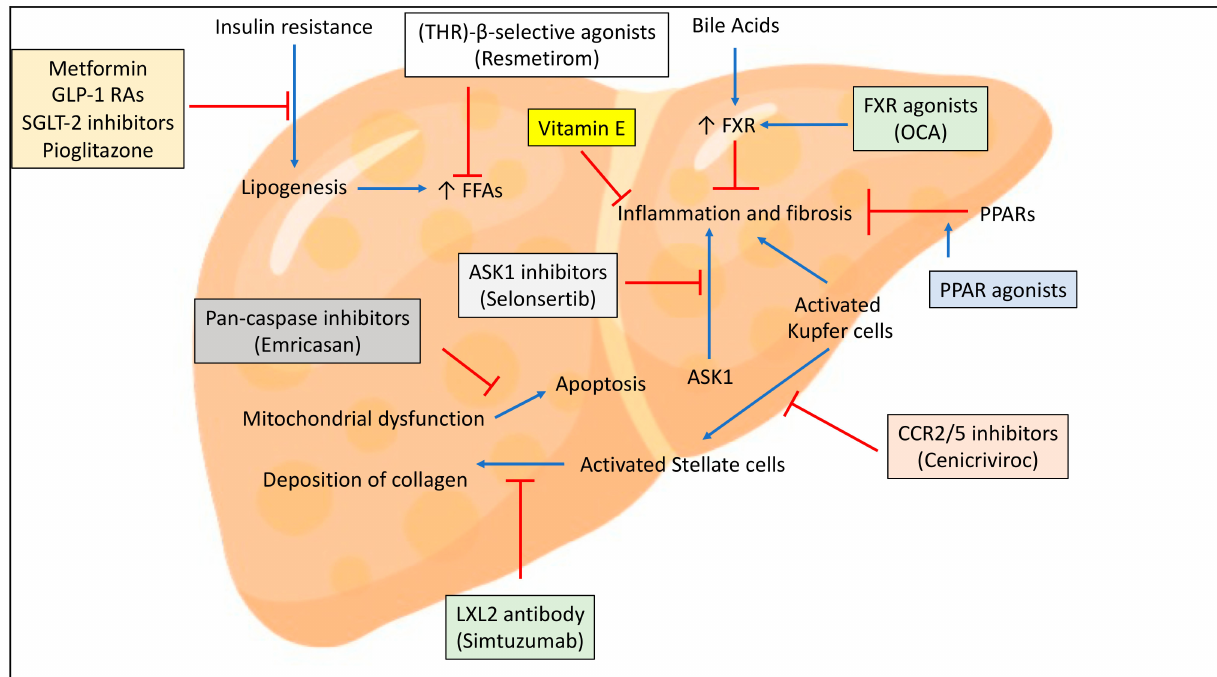
Figure 2. Main medications against NAFLD and its advanced forms and their mechanisms of action. See text for details. Note: Blue lines correspond to signal activation; red lines correspond to signal block. Abbreviations: ASK-1, apoptosis signal-regulating kinase-1; FFA, free fatty acids; FXR, farnesoid X receptor; GLP-1 RAs, glucagon-like peptide-1 receptor agonists; LOXL-2, lysyl oxidase-like 2; OCA, obeticholic acid; PPAR, peroxisome proliferator activated receptor; SGLT-2, sodium-glucose co-transporter-2; THR, thyroid hormone